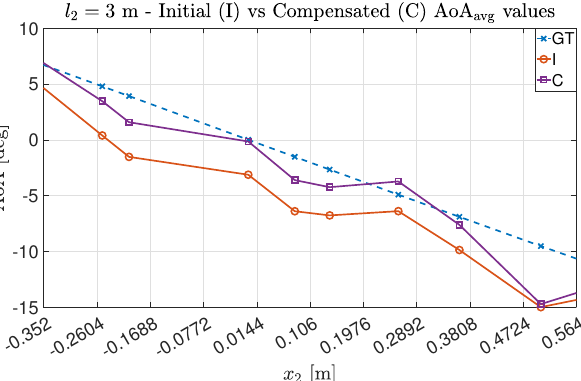
Figure 11. Average AoA estimation values for Exp#2 before and after the compensation.